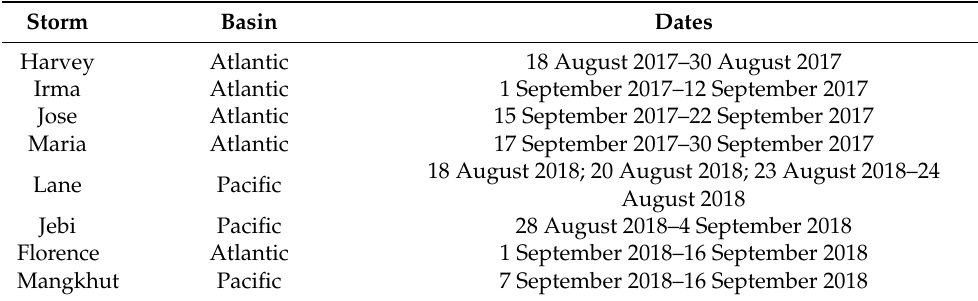
Figure 6. Comparison of AMSR2 and HWRF winds for Hurricane Dorian on 4 September 2019 for an AMSR2 pass at 7:32 UTC. Top panels: the HWRF winds before resampling for the HWRF analysis times before ( a ) and after ( b ) the corresponding SMAP pass. Bottom panels: the resampled HWRF winds at analysis times before ( c ) and after ( e ) the AMSR2 pass ( d ). Table 1. The 19 storms analyzed in this study, along with the dates during their lifetimes for which available satellite overpasses were compared to HWRF data. A full list of satellite passes over each of these storms is provided in the Supplementary Materials.